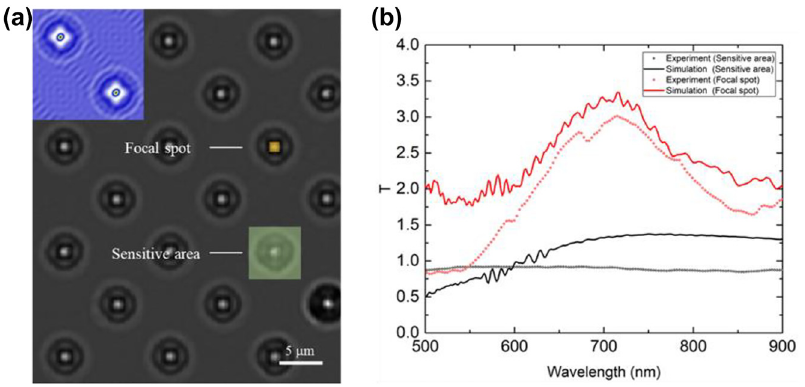
Figure 5: Transmission spectrum of axicon metalens with different measuring areas. (a) Measured optical microscope image of the axicon metalens array illuminated by collimated white light. The scale bar is shown in the image. Green and orange squares represent the collection area at the focal spot and at the sensitive area, respectively. The inset is the simulated intensity distribution at 𝜆 = 700 nm. (b) Transmission spectrum normalized to film with a thickness of 150 nm. Red and black represent the transmission spectrum at the focal spot and at the sensitive the transmission of a TiO 2 area, respectively. Solid and dotted lines indicate the simulated and experimental results, respectively. The collection plane is 1 μ m above the surface of the